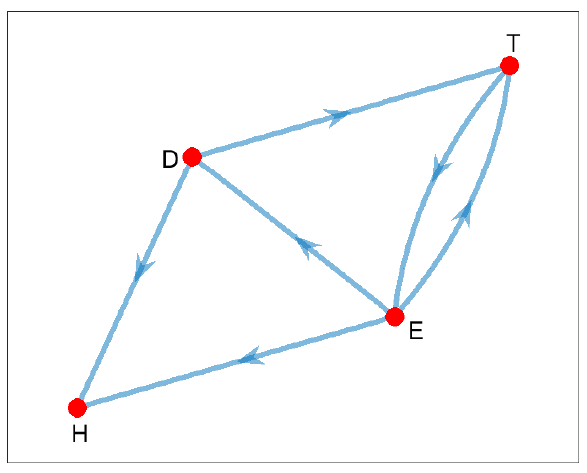
Figure 3. Graph of services and dependencies: Notation: E—power company; T—transport company; H—hospital; D—data